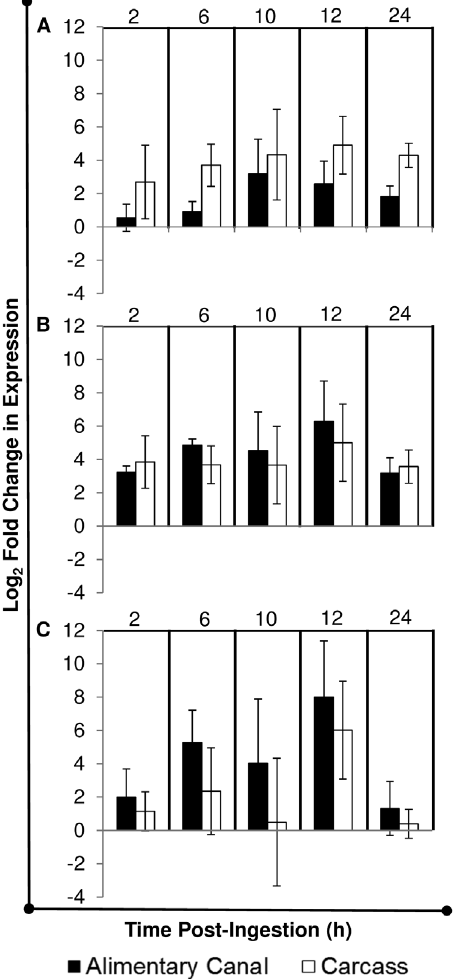
Figure 3. Systemic and local antimicrobial peptide gene expression in house flies that ingested GFP- P.aeruginosa . House flies (n=25 in each of three replicates) were fed an average 3.41 6 10 5 CFU (SD=5.77 6 10 3 ) of GFP- P. aeruginosa and at 2, 6, 10, 12, and 24 h post-ingestion, flies (n=5 per replicate) were dissected to separate the digestive tracts and carcasses which were pooled within replicate/time point for qRT-PCR analysis. Fold changes cecropin (A), defensin (B), and diptericin (C) expression were calculated using the REST-MCS (cid:1) software by calibrating to AMP expression levels in broth-fed adult flies and using the reference gene rps18 . Mean log 2 -fold changes in expression are shown, and error bars are standard error. Refer to Table S2 for REST- MCS analysis of systemic and local AMP expression for each